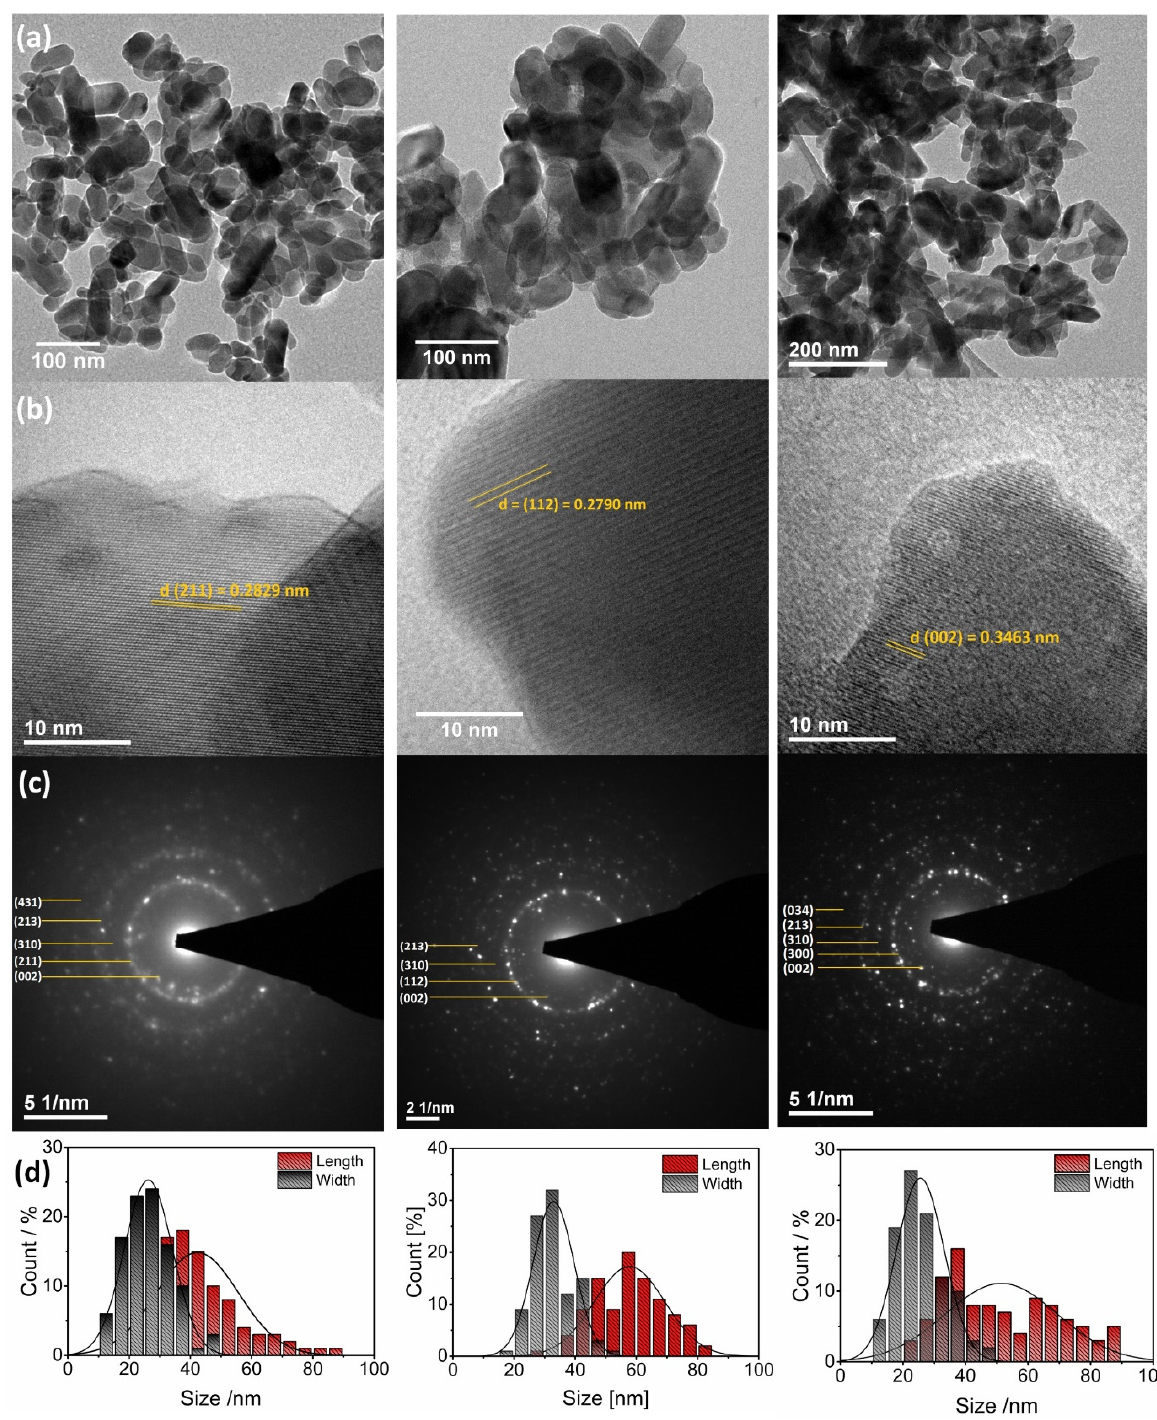
Figure 4. TEM ( a , b ) and SAED ( c ) images of the Ca 10 (PO 4 ) 6 (OH) 2 ( left ), Ca 10 (PO 4 ) 6 Cl 2 ( middle ), Ca 10 (PO 4 ) 6 F 2 ( right ) co- doped with 1 mol% Eu 3+ and 2 mol% Li + prepared at 500°C with the indication of lattice spacing and crystal planes (hkl). Histogram ( d ) of the grain size distribution (length and width diameters) of the apatites. One of the crucial parameters responsible for cell ‒ nanomaterial interaction is the sur- face charge of both elements. There is a potential between the surface of the particles and the dispersing liquid, which changes with distance from the surface of the particle. This po- tential measured for the slipping plane is called zeta potential ( z ) [50]. For clarity, the slip- ping plane is a boundary within the area of the diffusion layer. When the particle moves, the ions within that boundary move with it, but not any ions located outside that boundary.